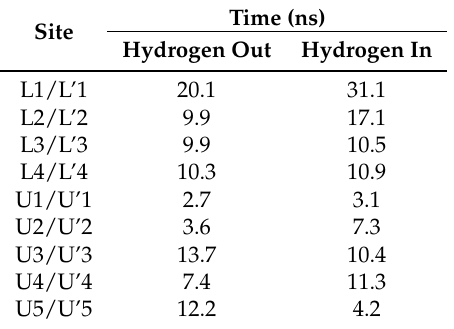
Table 1. Residence times of waters around sites with the terminology of sites specified in Figure 6 using fits shown in Figures S4 and S5. The column with ”Hydrogen Out” refers to the step where the hydrogens of the hydrogen phosphate are pointed outward towards the bulk water and ”Hydrogen In” refers to the step where the hydrogens of the hydrogen phosphate are pointed inward towards the bulk phosphate. Time (ns) Site Hydrogen